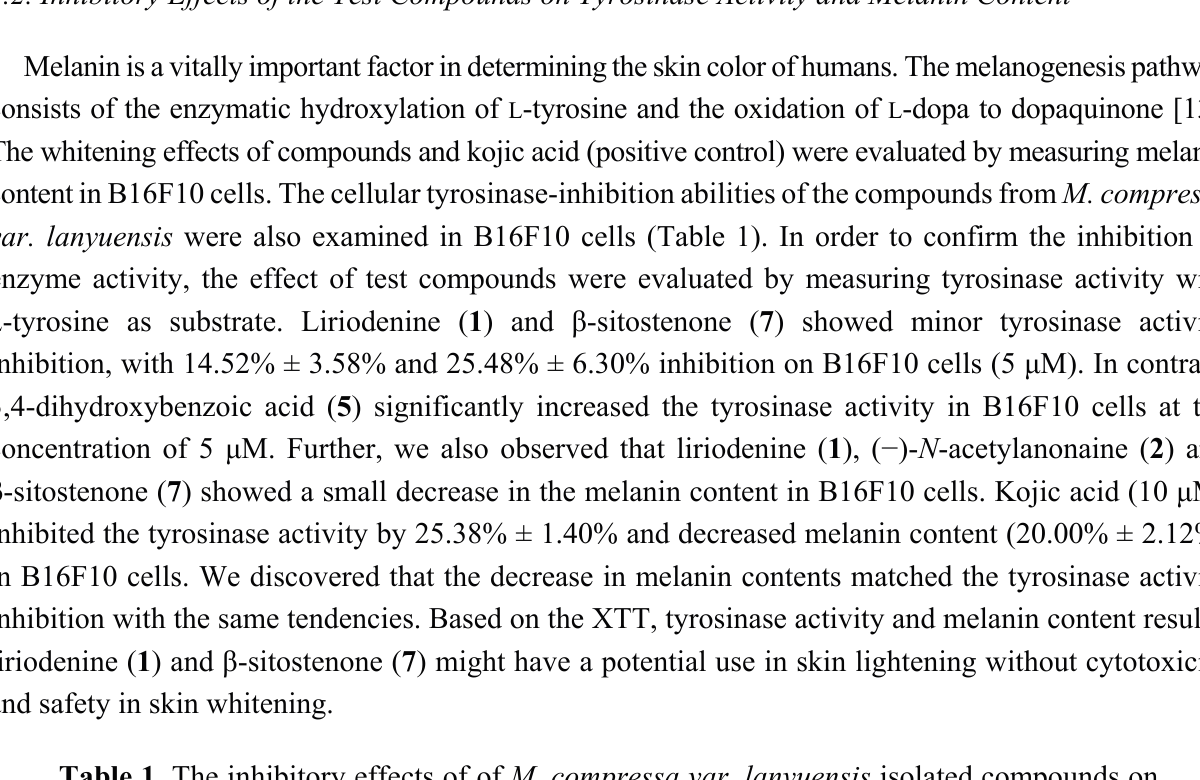
Table 1. The inhibitory effects of of M. compressa var. lanyuensis isolated compounds on tyrosinase activity and melanine content formation in melanoma